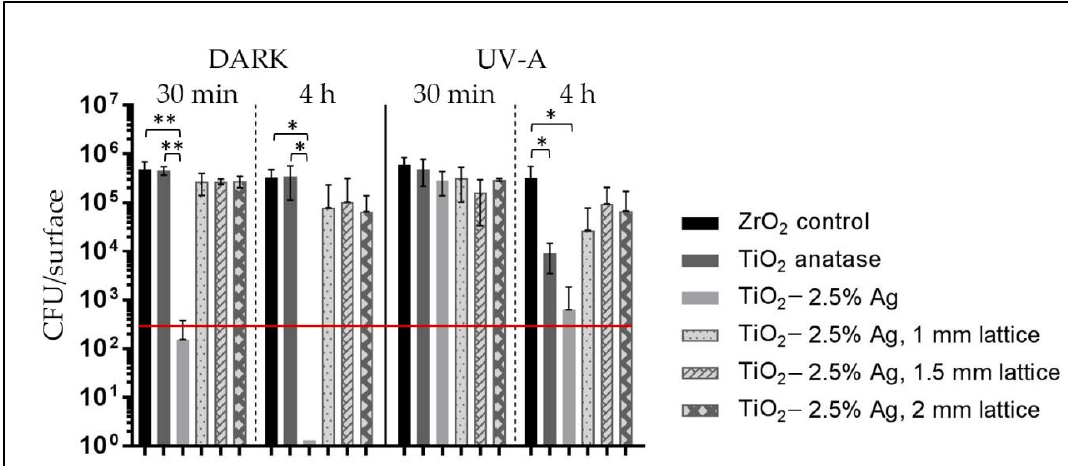
Figure 8. Viability of Escherichia coli MG1655 on ceramic and composite hybrid surfaces after 30 min and 4 h exposure in the dark and UV-A-illumination. Columns represent recovered viable bacteria as colony forming units (CFU). Mean and standard deviation of at least three independent values is shown on a logarithmic scale and only statistically significant differences ( p < 0.05) marked on the graph (* p < 0.05 and ** p < 0.01). Only the upper error bar is shown for samples with >100% SD. Lattice samples are excluded from statistical analysis at 4 h time points due to very high variability. Limit of detection at 458 CFU/surface marked in red.